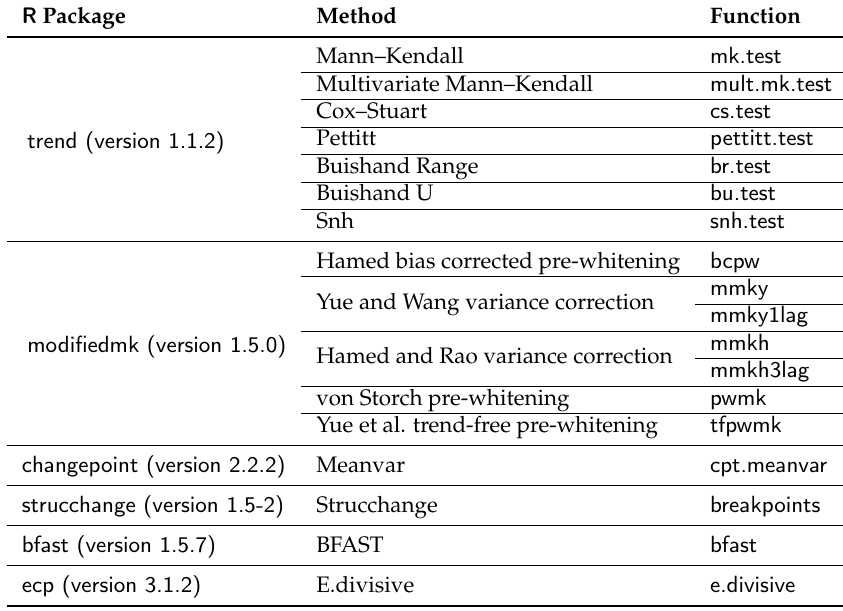
Table 1. R packages, methods, and functions used in the simulation